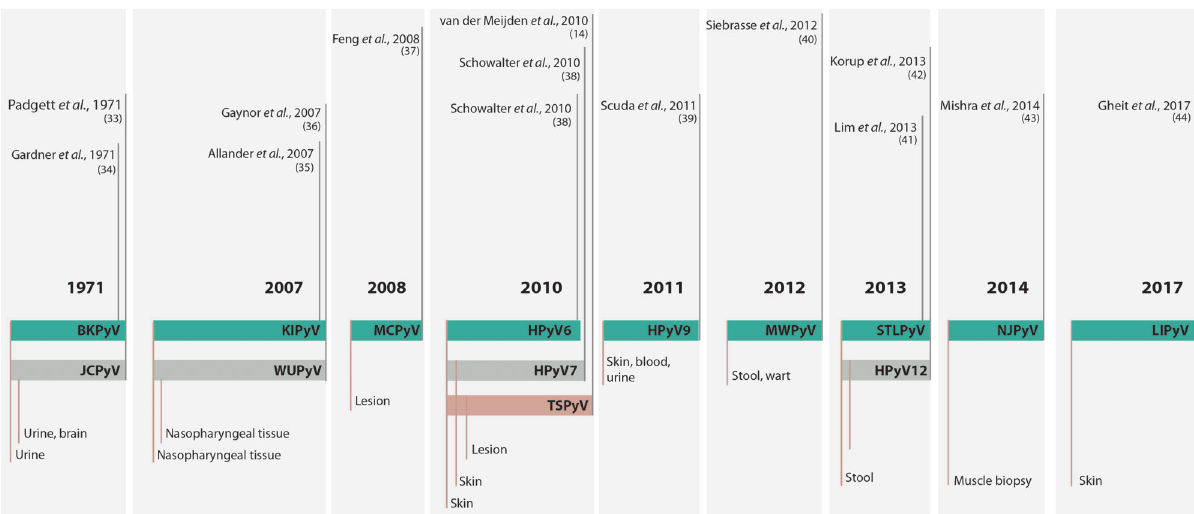
Figure 1 - Timeline of the discovery of human polyomaviruses. The timeline shows the name of the virus, the year of discovery and the type of sample from which the virus was isolated. For complete references, see the text. BKV or BKPyV, human polyomavirus BK or human polyomavirus 1; JCV or JCPyV, John Cunningham or JC polyomavirus or human polyomavirus 2; KIPyV, Karolinska Institute polyomavirus or human polyomavirus 3; WUPyV, Washington University polyomavirus or human polyomavirus 4; MCPyV, Merkel cell polyomavirus or human polyomavirus 5; HPyV6, human polyomavirus 6; HPyV7, human polyomavirus 7; TSPyV, Trichodysplasia spinulosa polyomavirus or human polyomavirus 8; HPyV9, human polyomavirus 9; MWPyV, Malawi polyomavirus or human polyomavirus 10; STLPyV Saint Louis polyomavirus or human polyomavirus 11; HPyV12, human polyomavirus 12; NJPyV, New Jersey polyomavirus or human polyomavirus 13; LIPyV, Lyon IARC polyomavirus or human polyomavirus